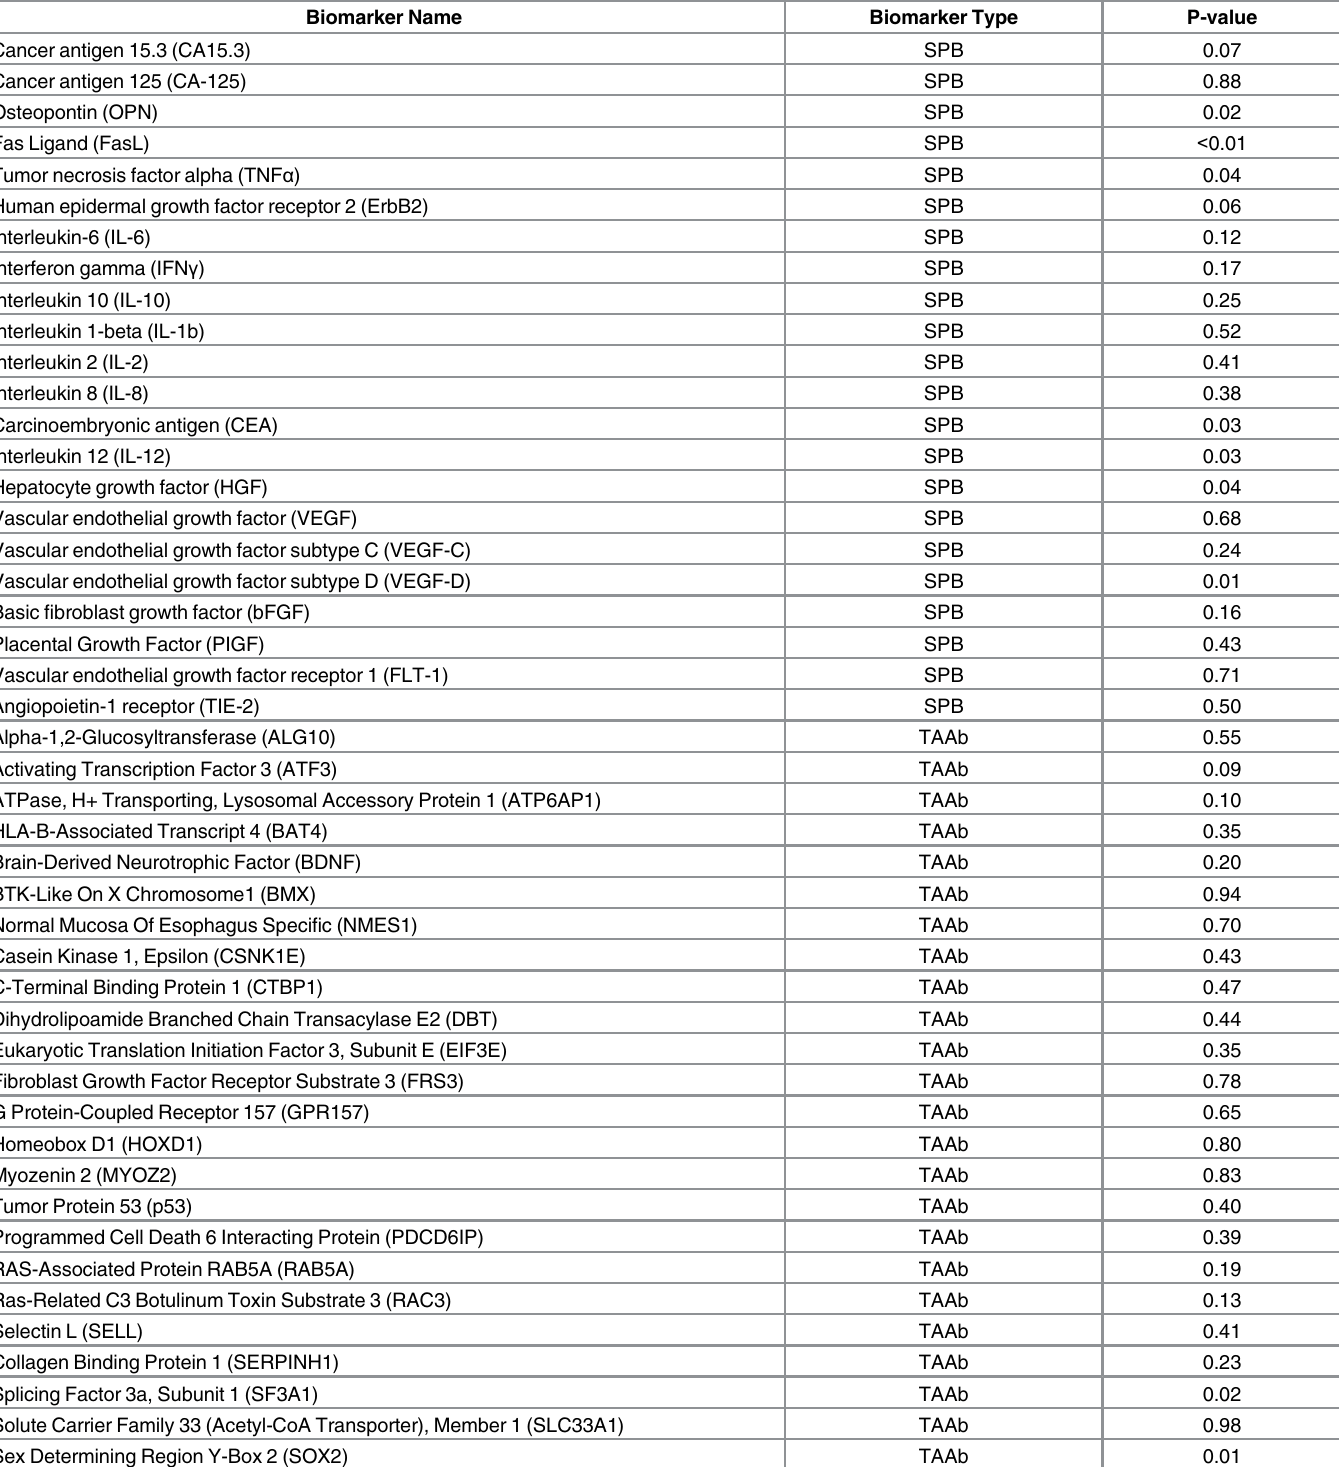
Table 2. Serum Protein Biomarkers and Tumor associated autoantibodies evaluated. P -values are provided for each analyte in comparing non-BC (ND and BBD) to BC (two-tailed T-test assuming heteroscedastic variance). Glutathione S-transferase (GST) was used to normalize the TAAb ratio; the p - value in parentheses refers to the mean GST MFI across all